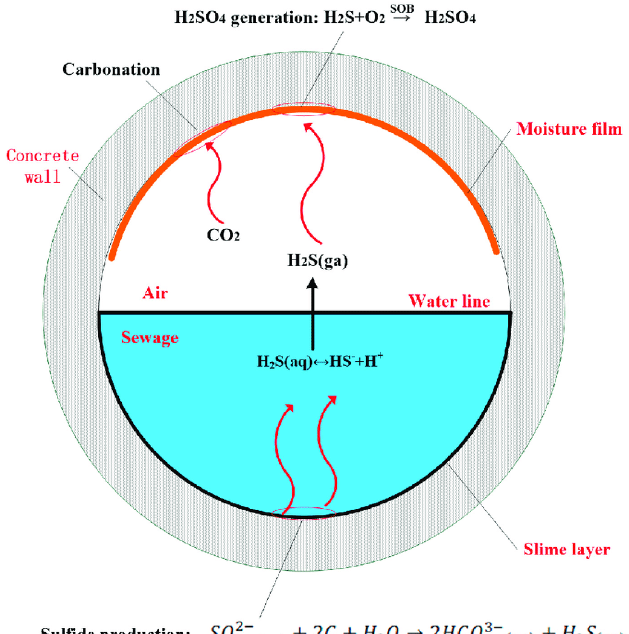
Figure 1. The sulfur cycle in the sewer system [31].